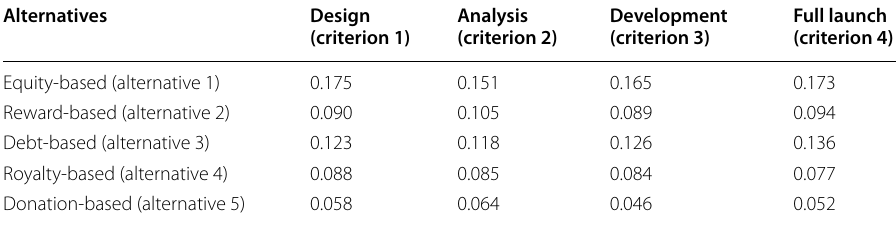
Table 24 Weighted decision